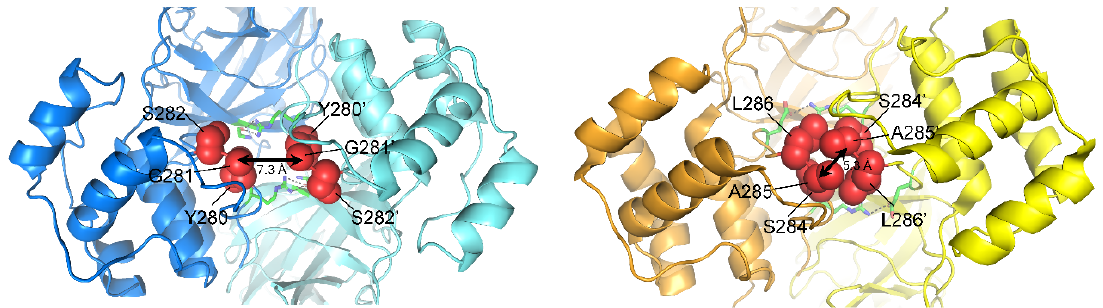
Figure 6. Comparison of the dimerization interfaces between ( A ) CCoV M pro and ( B ) SARS-CoV-2 M pro . The three critical residues forming hydrophobic core at the dimerization interface of SARS- CoV-2 M pro (S284-A285-L286) are shown in red spheres as compared with those of CCoV M pro (Y280-G281-S282). The residues that participate in forming salt bridges (R4-E290 in SARS-CoV-2 M pro ) and hydrogen bonding (R4-G126 in CCoV M pro ) are shown as green sticks. The distances between the C α atom of G281s or A285s are indicated.